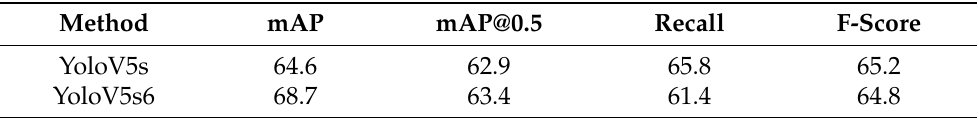
Table 1. Comparison among YoloV5s-P5 and YoloV5s6-P6 as baseline architectures. mAP is computed in (%) at IoU = 0.5:0.05:0.95, while mAP@0.5 is computed at 50% IoU.